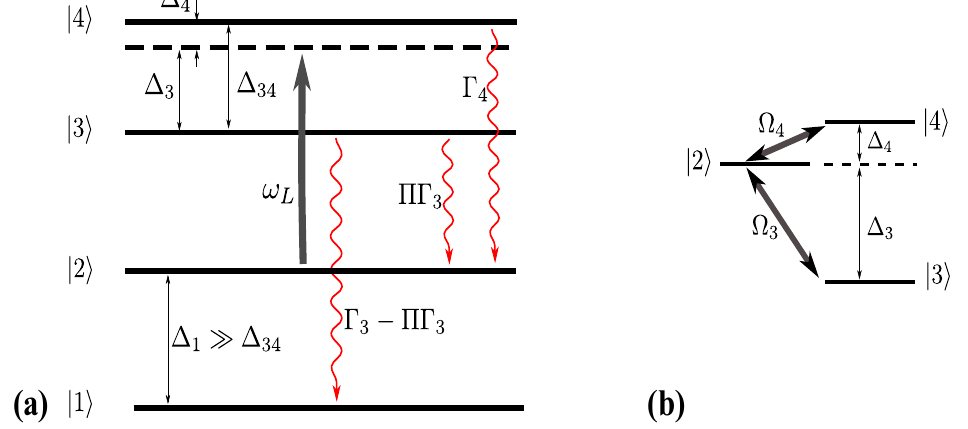
Figure 6. ( a ) schematic illustration of a three-level system having a cyclic transition | 4 (cid:105) → | 2 (cid:105) and a partially open transition | 3 (cid:105) → | 2 (cid:105) with the branching factor Π . The additional passive state | 1 (cid:105) accumulates the population due to the spontaneous transition | 3 (cid:105) → | 1 (cid:105) ; ( b ) the same scheme in the rotating wave approximation. The bare ground state | 2 (cid:105) is selected as the position of zero energy (dashed horizontal